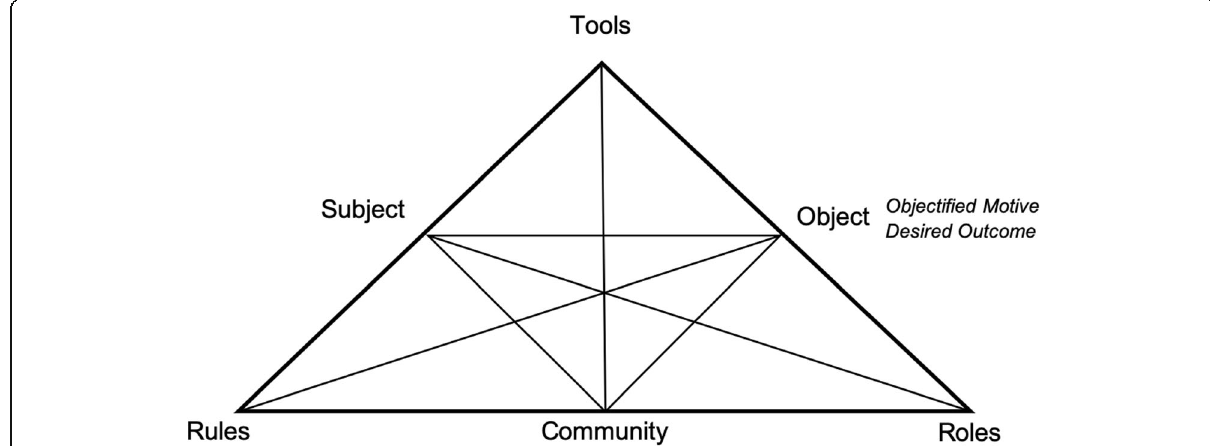
Fig. 1 Activity system components and connections. This figure is based on conceptualizations of second-generation cultural-historical activity theory in Engeström (2014) and Engeström